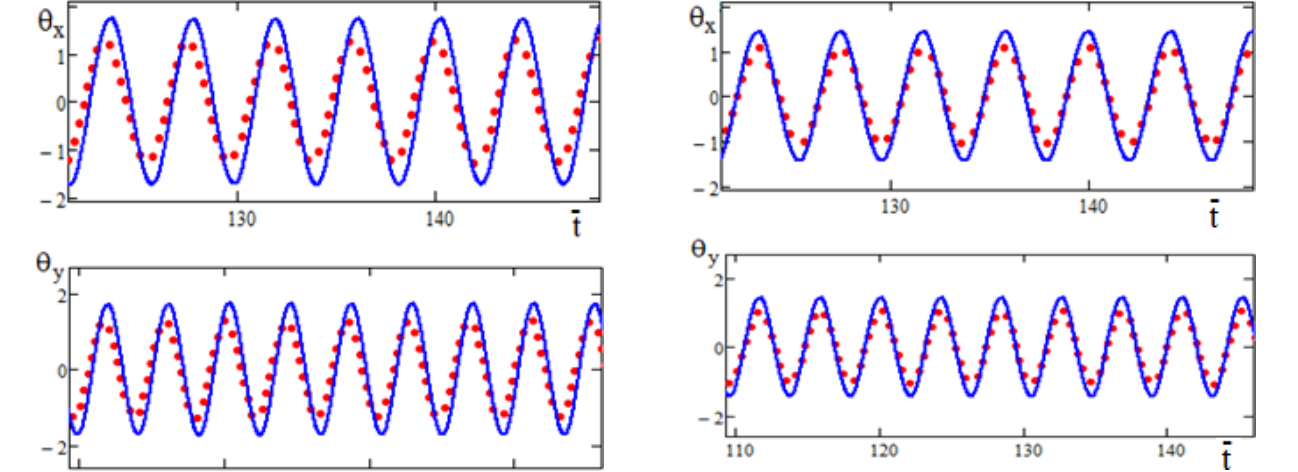
Figure 3. Oscillogram θ x = θ x ( t ) and θ y = θ y ( t ) when K 3 = 0 . 075 , µ 1 = 0 . 09 ,µ 3 = 0 . 18. Solid lines are the results of a numer- ical solution, points are the results of an analytical